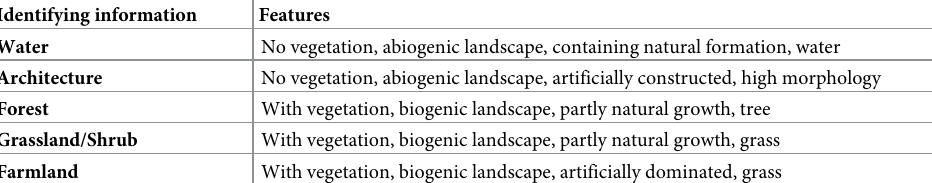
Table 1. Initial classification characteristics of scenic